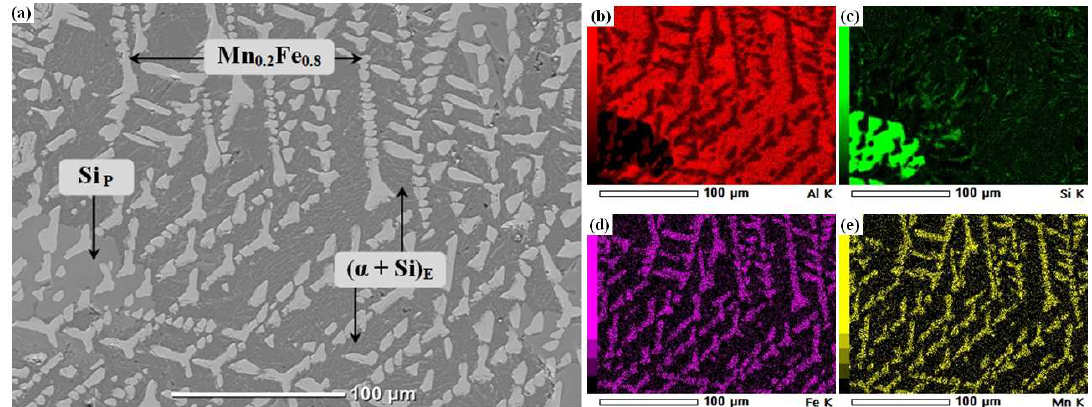
Figure 15. ( a ) Backscattered electron image of AlSiFe with 5 wt. % Mn alloy. Elemental mapping of ( b ) aluminum, ( c ) silicon, ( d ) iron, and ( e ) manganese. Si p = Primary silicon, (α+Si) E = Eutectic.